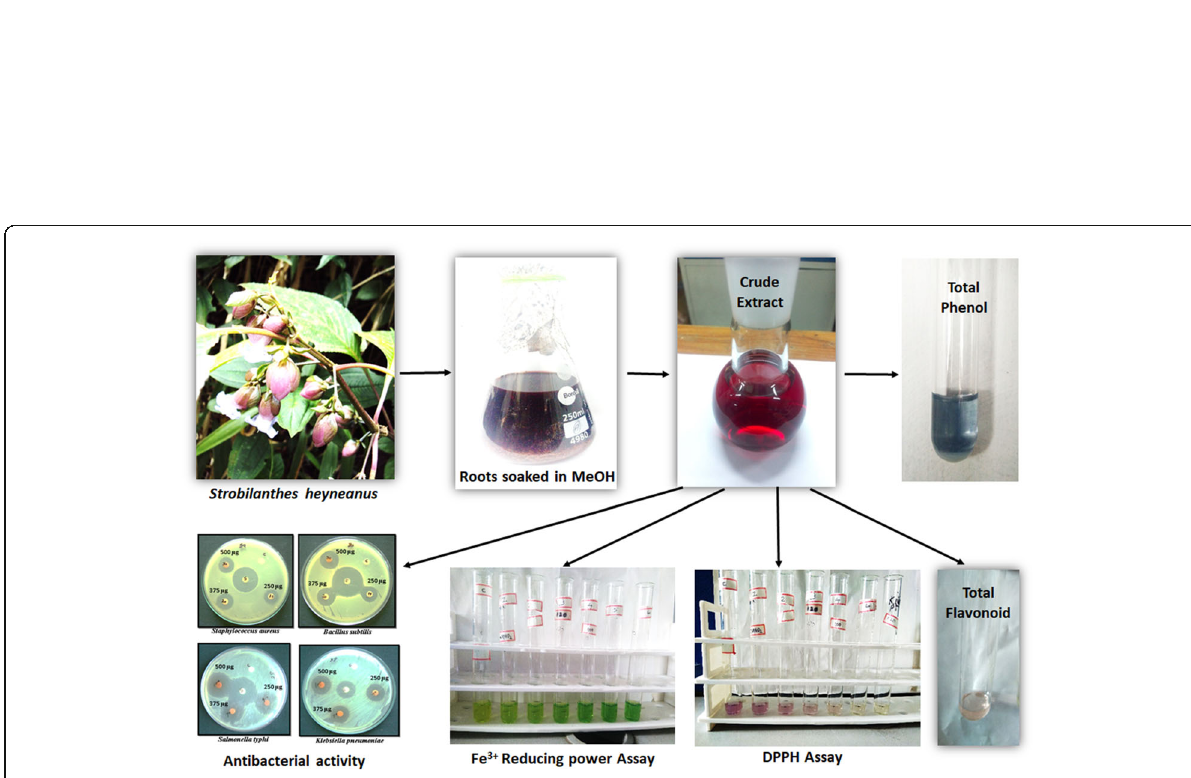
Fig. 9 ToC figure: pictorial representation of antioxidant and antibacterial activities of S.